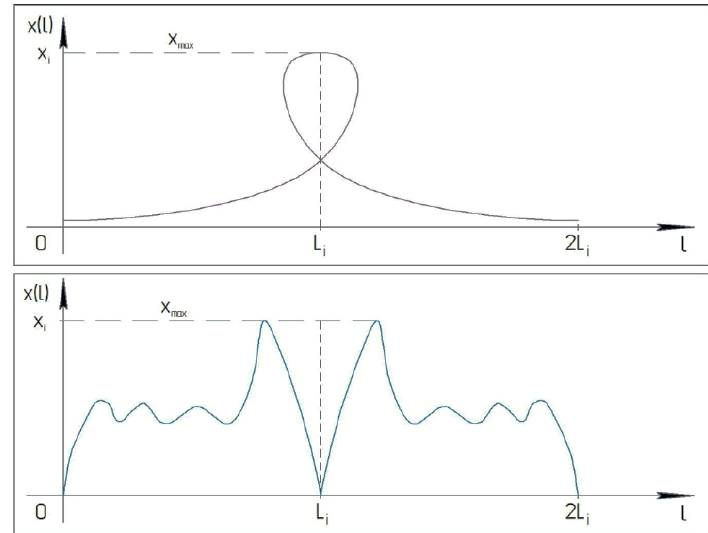
Figure 4. The described symmetric mappings relative to ordinates - their use makes it possible to close the curve for which the parametric form was